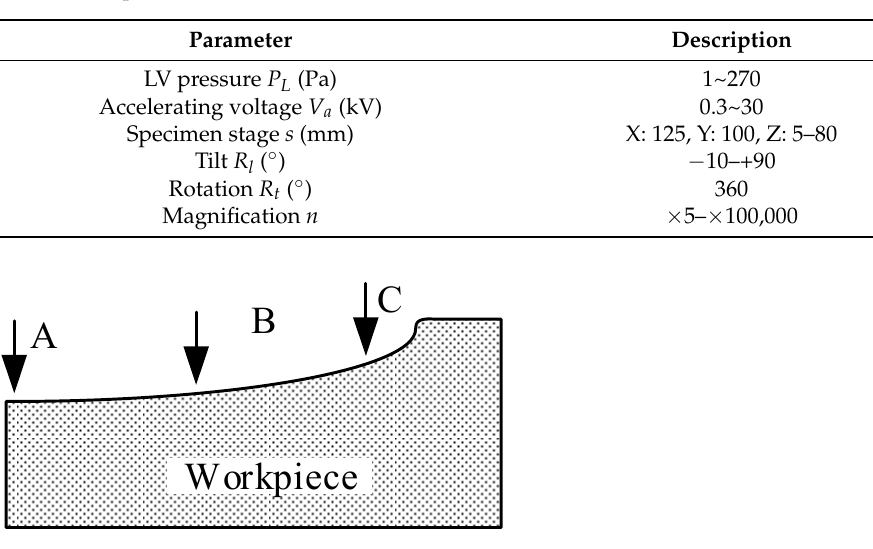
Figure 15. Positions on the surface of the pit.